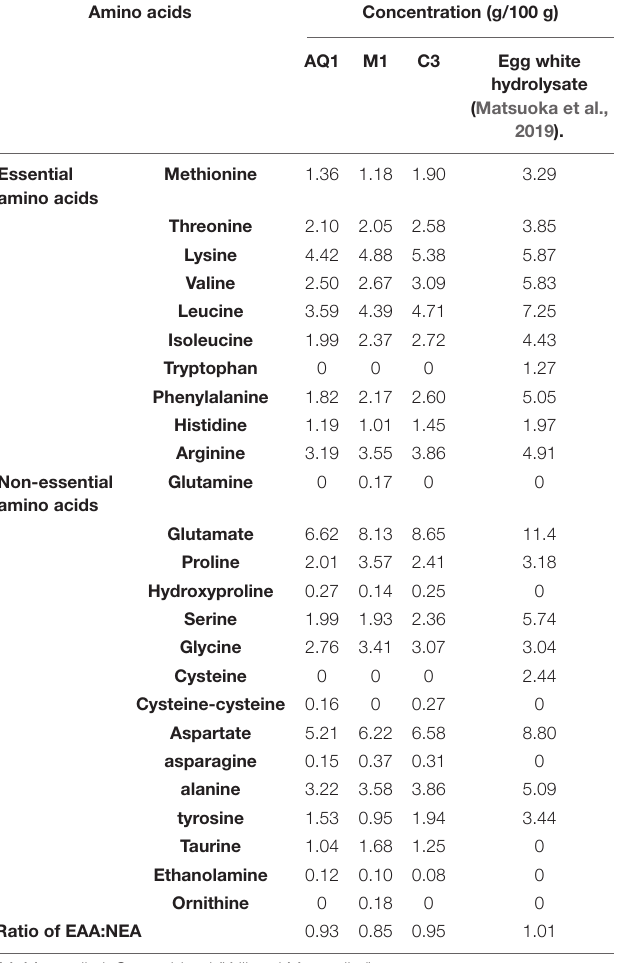
TABLE 2 | Amino acid composition (mM) of mesopelagic Hydrolysates M1 and C3 and aqueous extract AQ1 compared to egg white hydrolysate. Amino acids Concentration (g/100